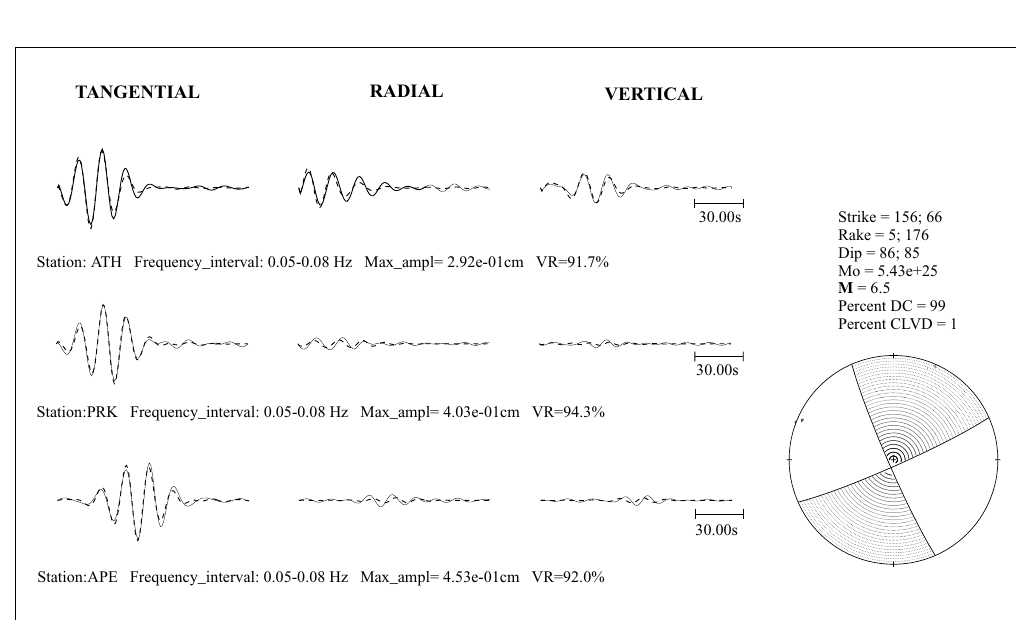
, and the moment magnitude, 0